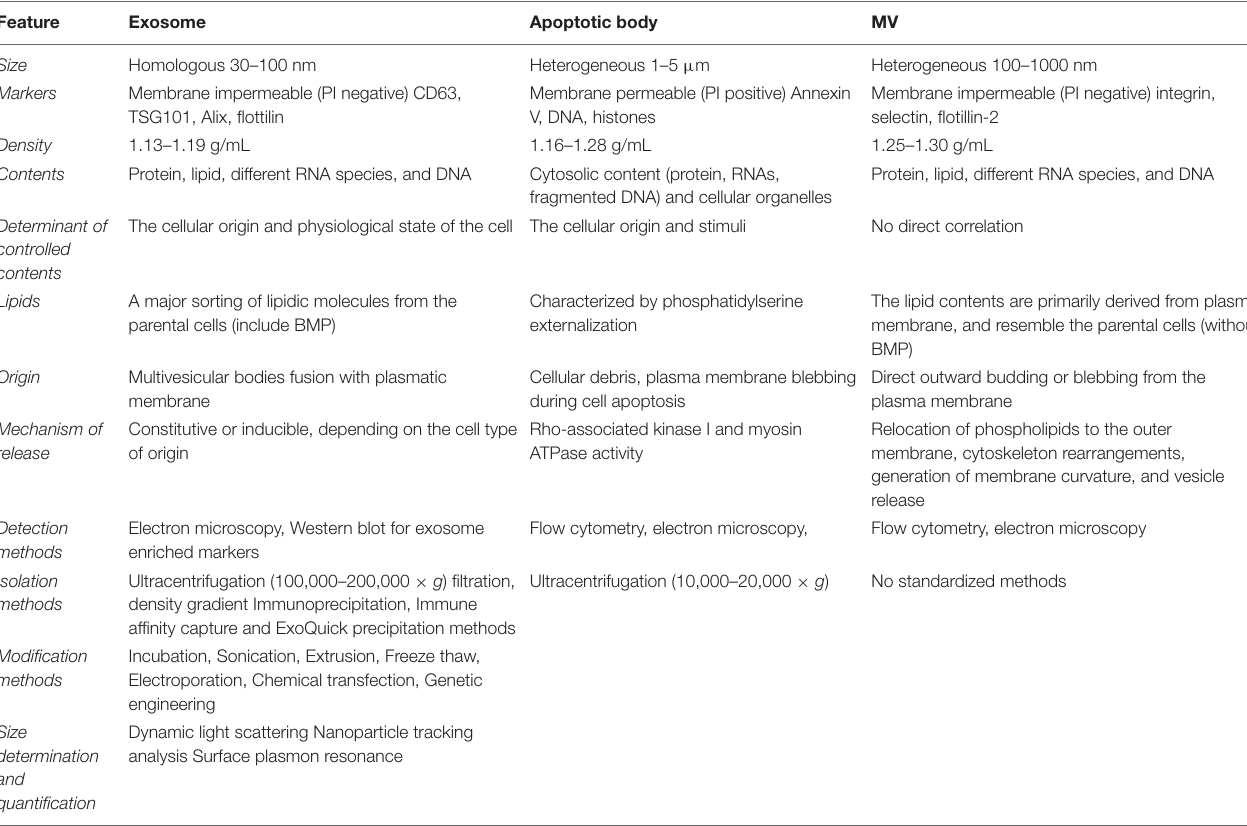
TABLE 2 | Different aspects of